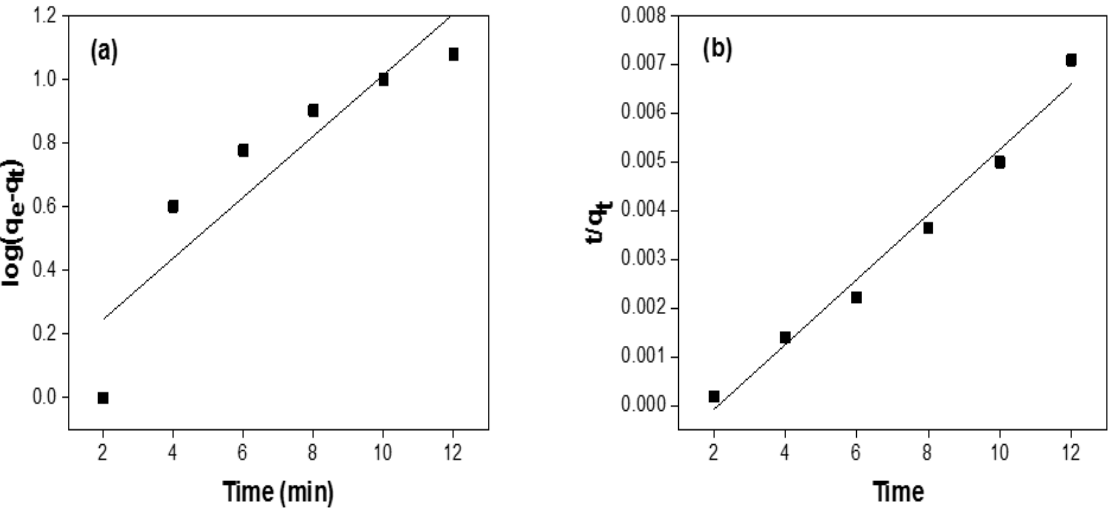
Figure 5. ( a ) Pseudo-first-order kinetics plot; ( b ) pseudo-second-order kinetics plot. Table 5. Kinetic data for the adsorption of MY on CPSMNPs.